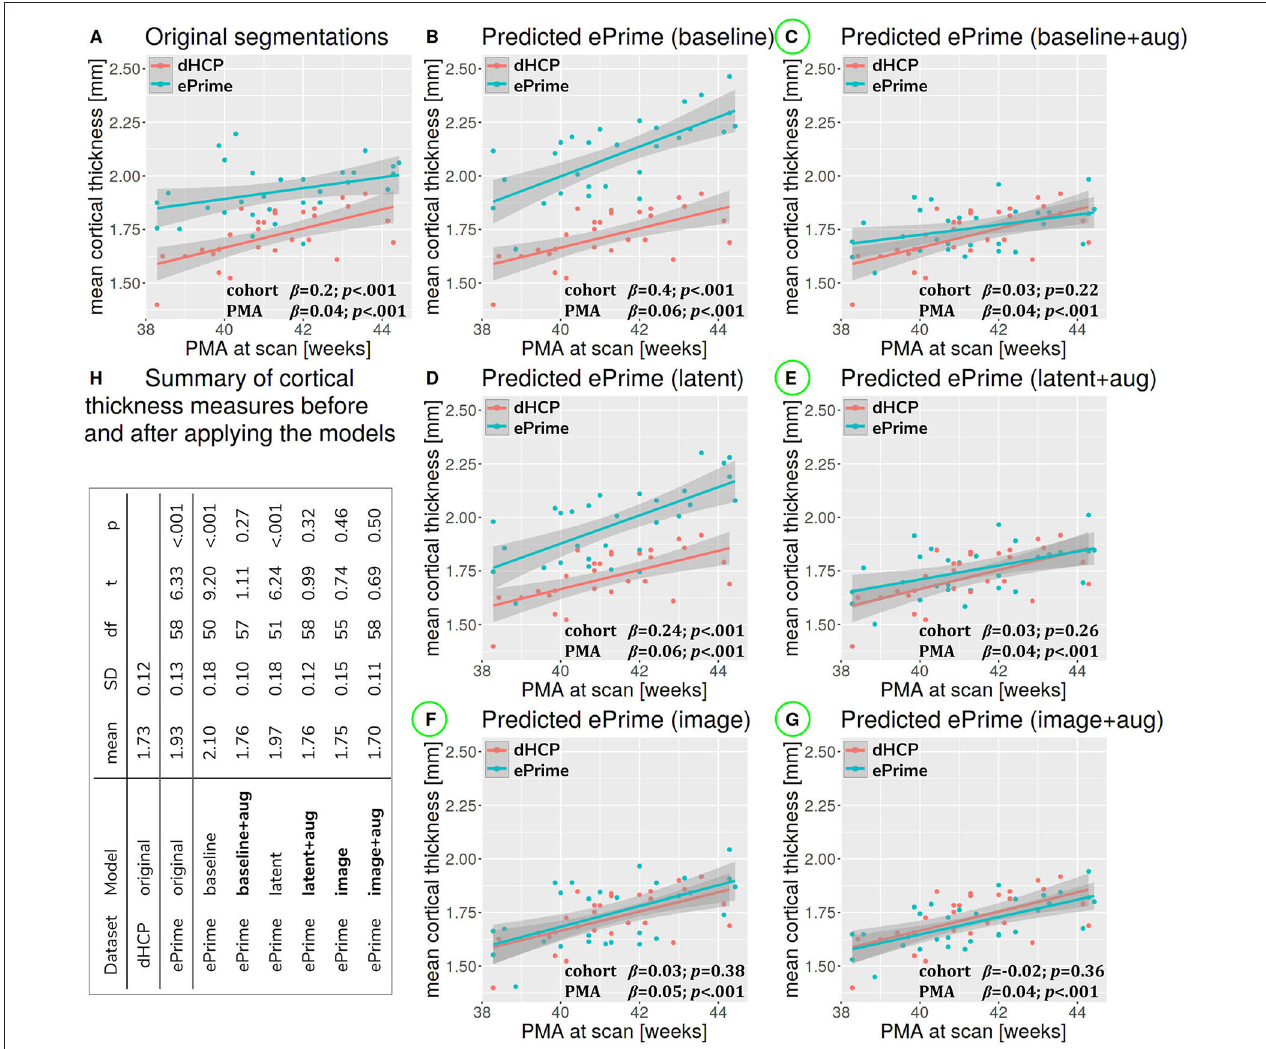
FIGURE 7 | The association between PMA and mean cortical thickness before (A) and after (B–G) applying the data harmonization models on the matched dHCP and ePrime subsets. A linear model regressing mean cortical thickness measures on PMA, GA, sex, and cohort revealed a significant effect of cohort for the original segmentations (A) , and the predicted maps ( B - baseline without augmentation and D - latent without augmentation ). The effect of cohort was rendered non-significant for four of the methods ( C - baseline with augmentation , E - latent with augmentation , F - image without augmentation , and G - image with augmentation ). (H) summarizes cortical thickness measures before and after applying the